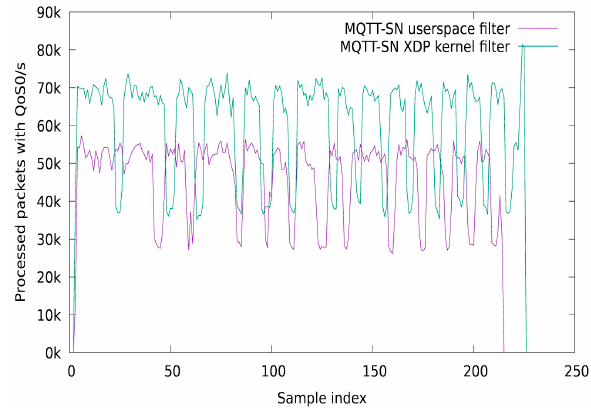
Figure 9. Processed packet rate (per second) in a DoS attack scenario.